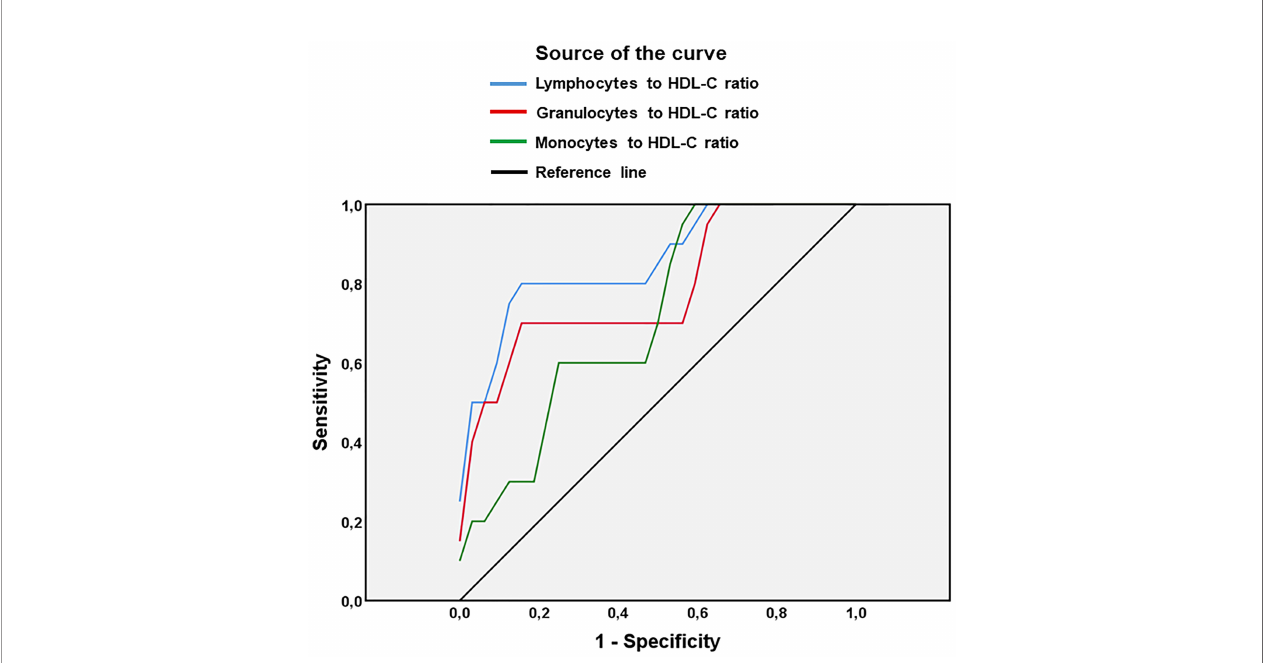
FIGURE 2 | Receiver Operating Characteristics (ROC) curve analysis of the value of ratios lymphocytes/HDL-C, granulocytes/HDL-C and monocytes/HDL-C for predicting gestational diabetes mellitus in pregnant women. HDL-C, high-density lipoprotein - cholesterol. n = 25 women with GDM, n= 35 pregnant women without GDM as control group.